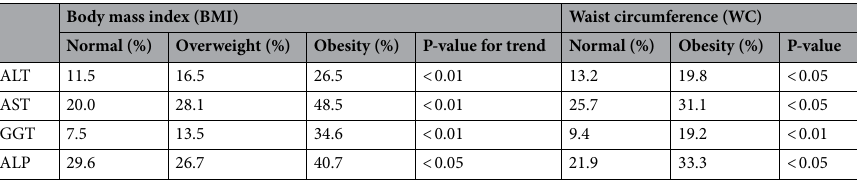
Table 3. Prevalence of elevated liver enzymes in the BMI and WC groups. Chi-square test was applied to derive the p-values.